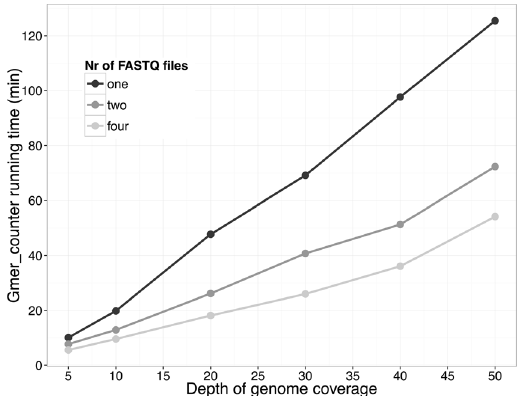
Figure 6. The time spent counting k -mer frequencies is proportional to the genome coverage (because of the larger FASTQ files). Gmer_counter is able to read data from multiple files simultaneously; thus, it runs faster if the sequence data are distributed between different files (e.g., files with paired